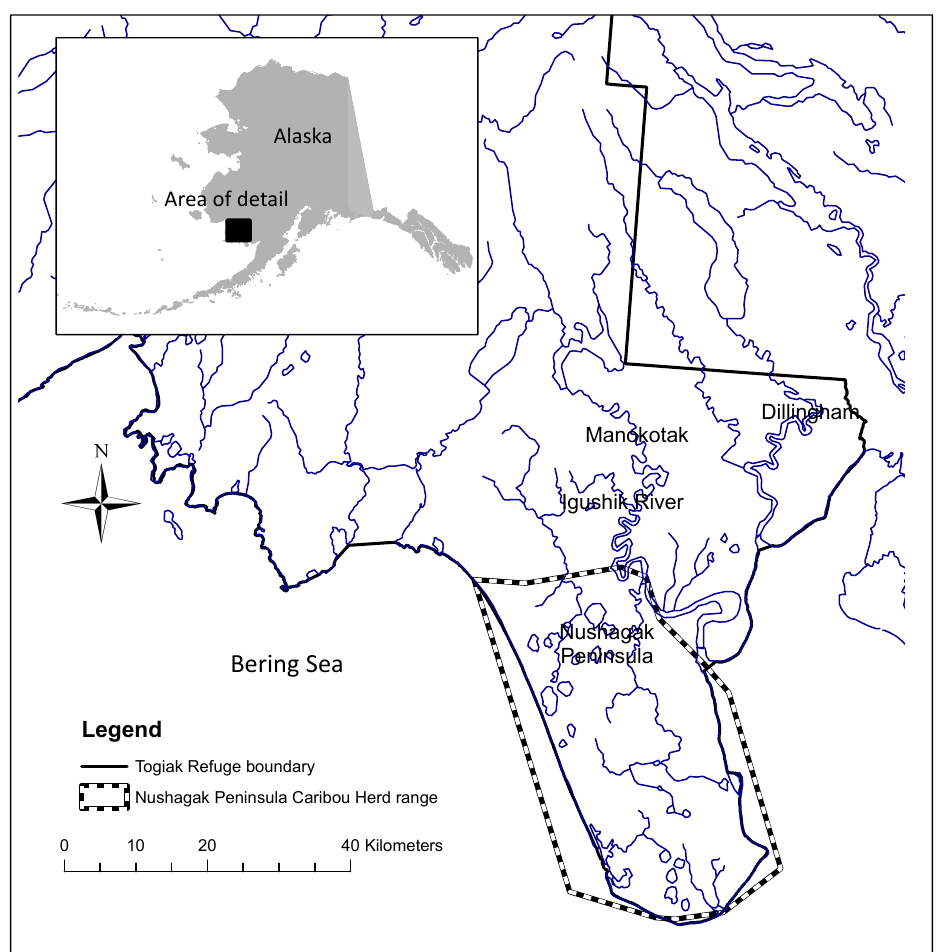
Figure 1. Study area, including Nushagak Peninsula plus adjacent headlands to a distance of approximately 50km, Togiak National Wildlife Refuge, southwestern